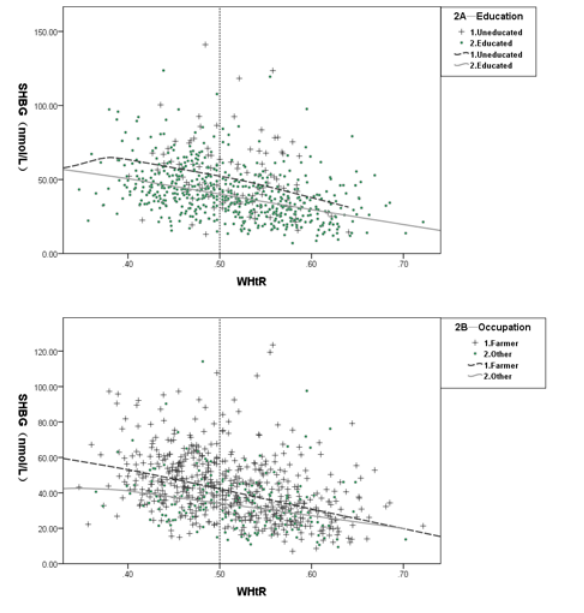
Figure 2: Relation between WHtR and SHBG level by sociological characteristics (A) education and (B) occupation.